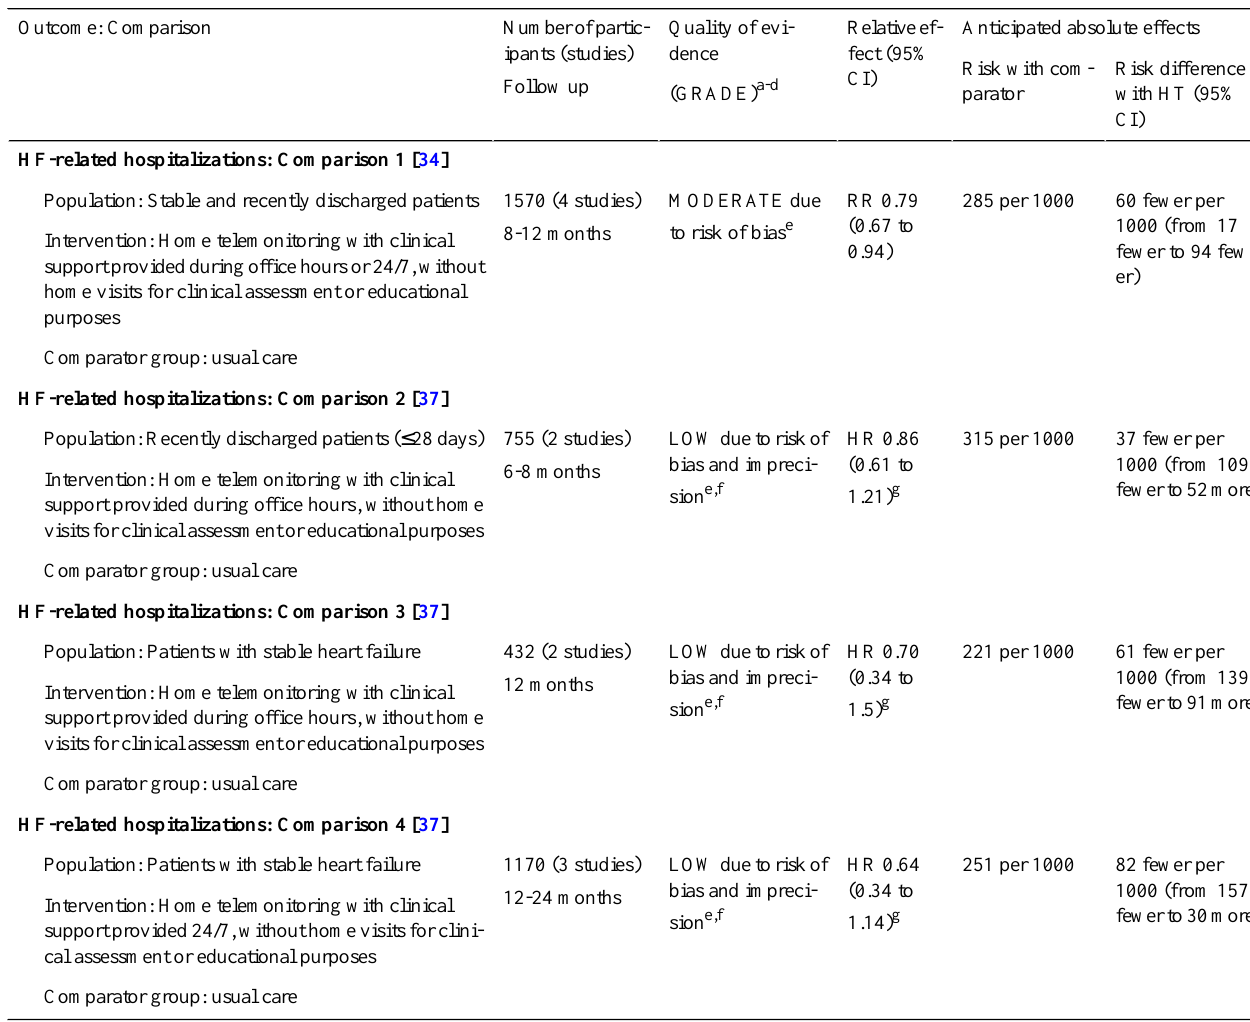
Table 9. Summary of findings from the meta-analyses with the most direct evidence in each group for the outcome of HF-related